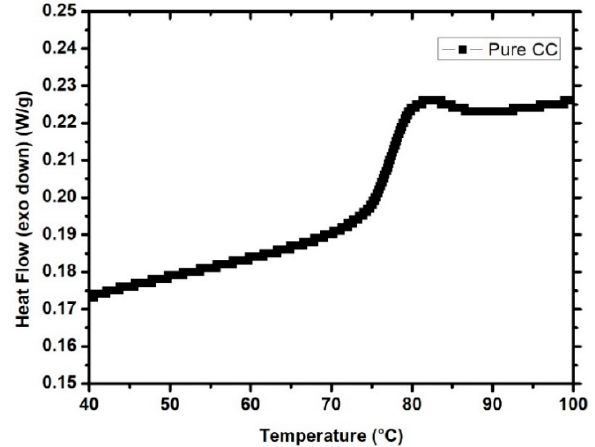
Figure 10. DSC run of pure CC.